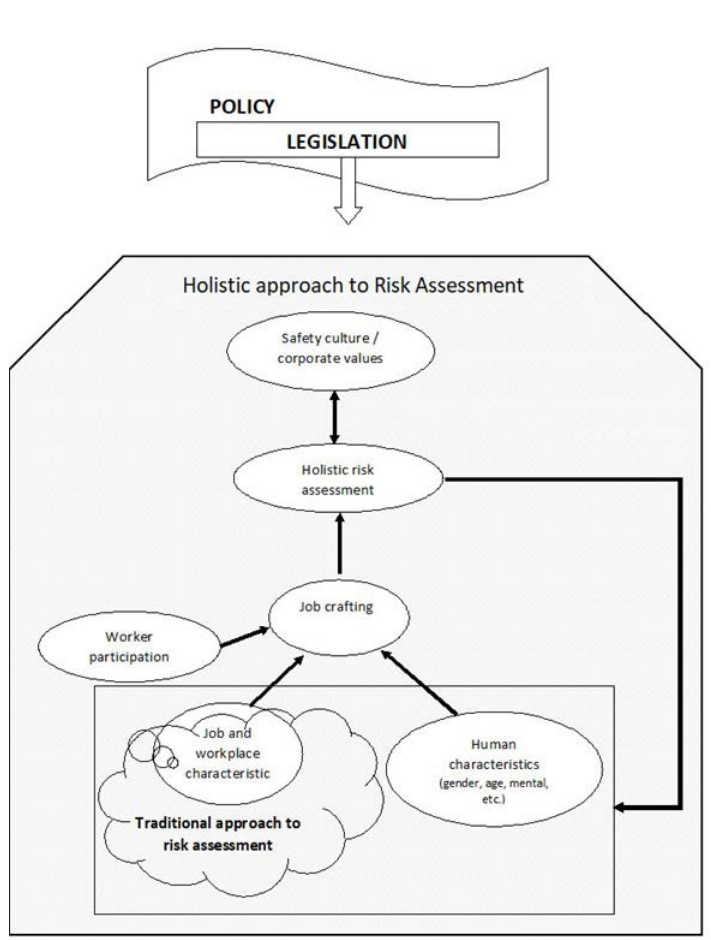
Figure 1. A framework for conducting a holistic Risk